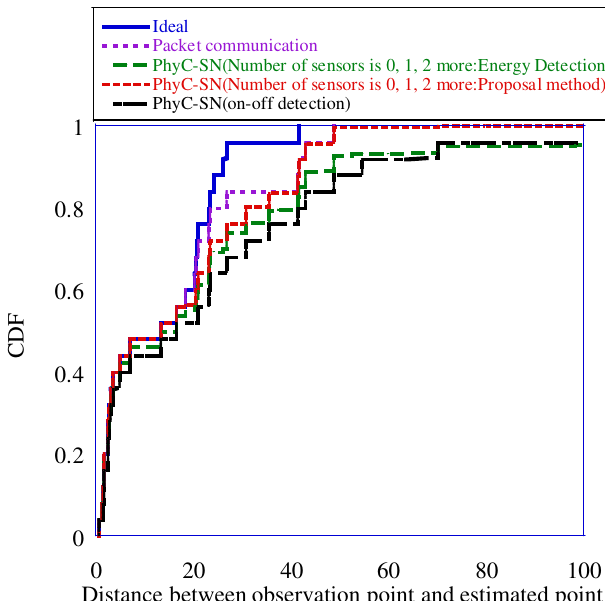
Figure 18. Positioning error at 64